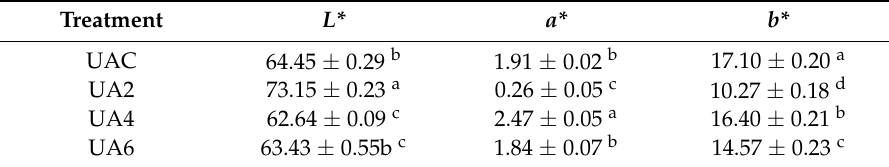
Table 2. Colour of gelatin extracted using ultrasound from bovine hide pretreated with enzyme actinidin. Values are presented as mean ± SE from triplicate